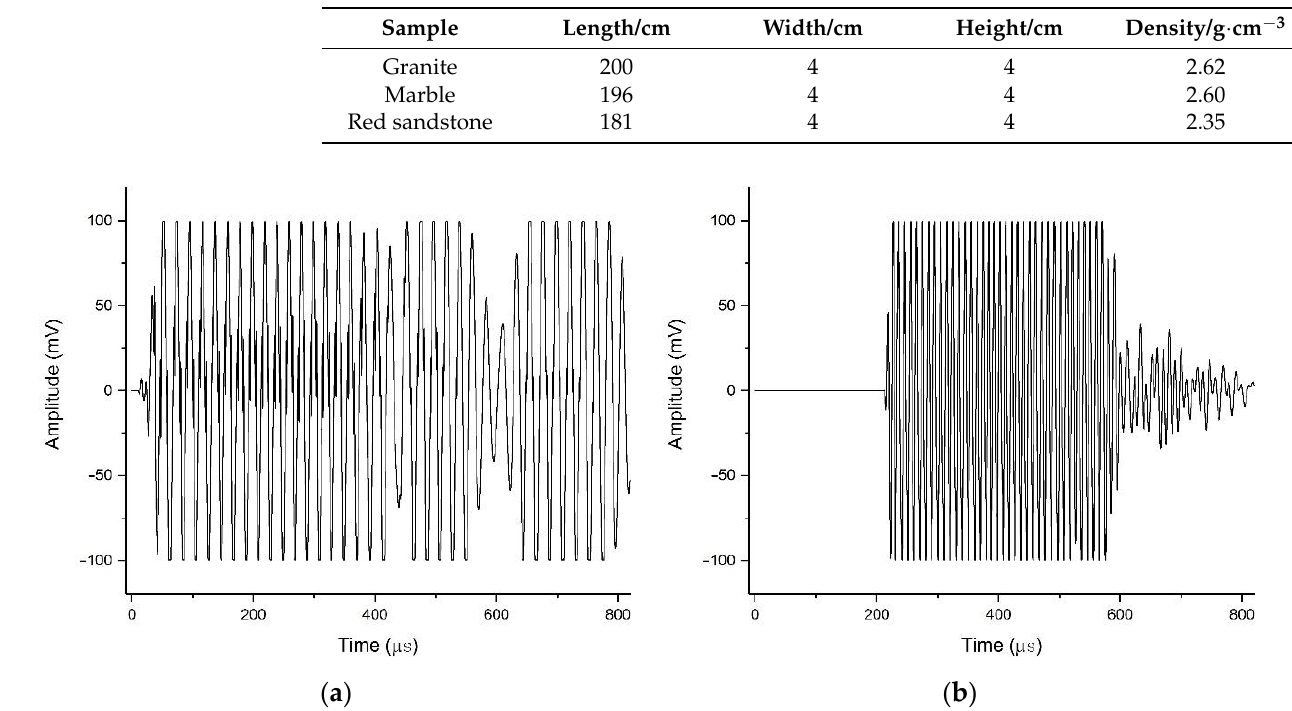
Figure 3. The waveform of the generated signal in ( a ) 50 kHz and ( b ) 100 kHz.